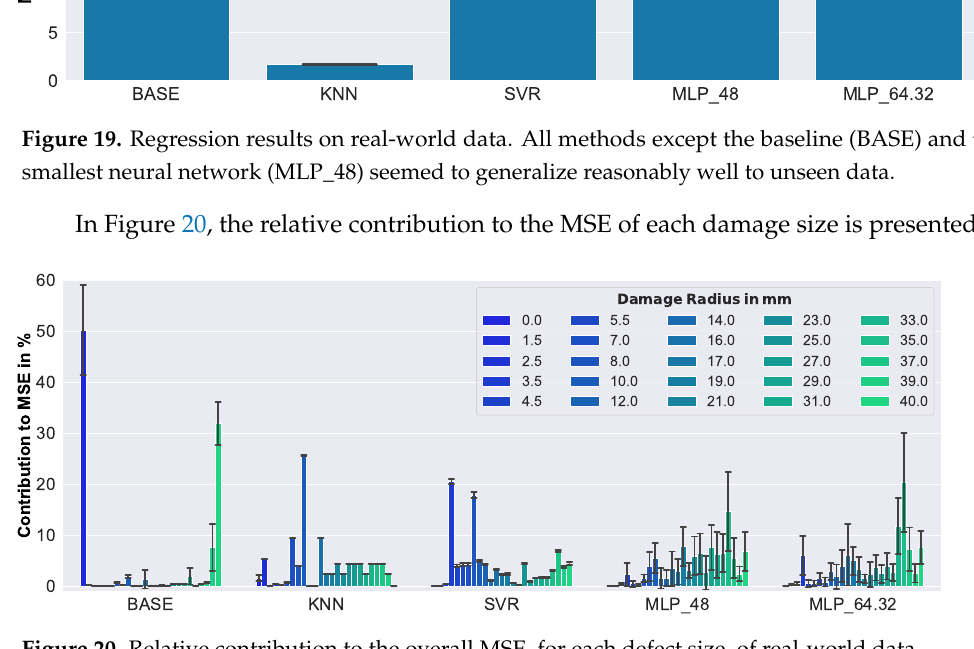
Figure 20. Relative contribution to the overall MSE, for each defect size, of real-world